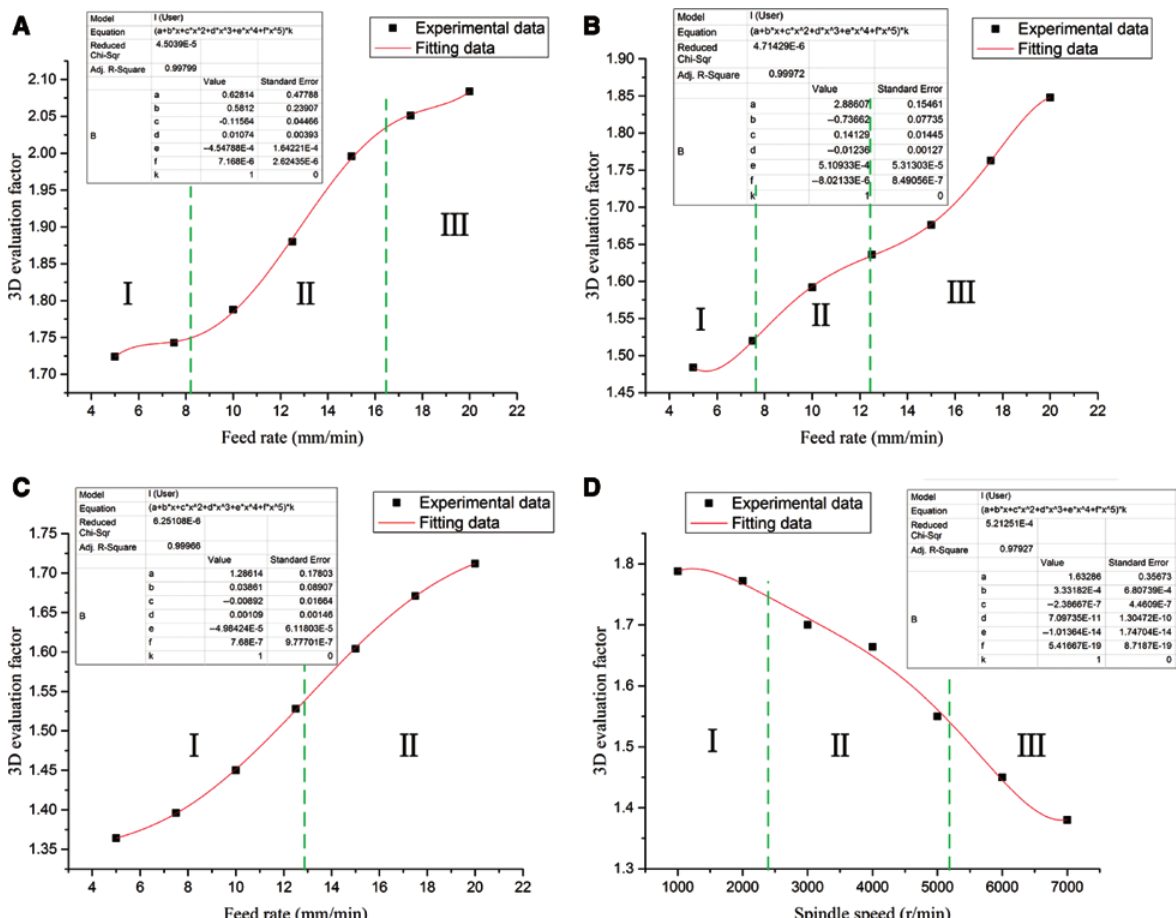
Figure 4: The relationship of the 3D evaluation factor ( Q ) and the feed rate (spindle speed) for the three drills. (A) Carbide drill under the same spindle speed (1000 r/min), (B) DLC drill under the same spindle speed (1000 r/min), (C) PCD drill under the same spindle speed (1000 r/min), and (D) PCD drill under the same feed rate (10 mm/min).